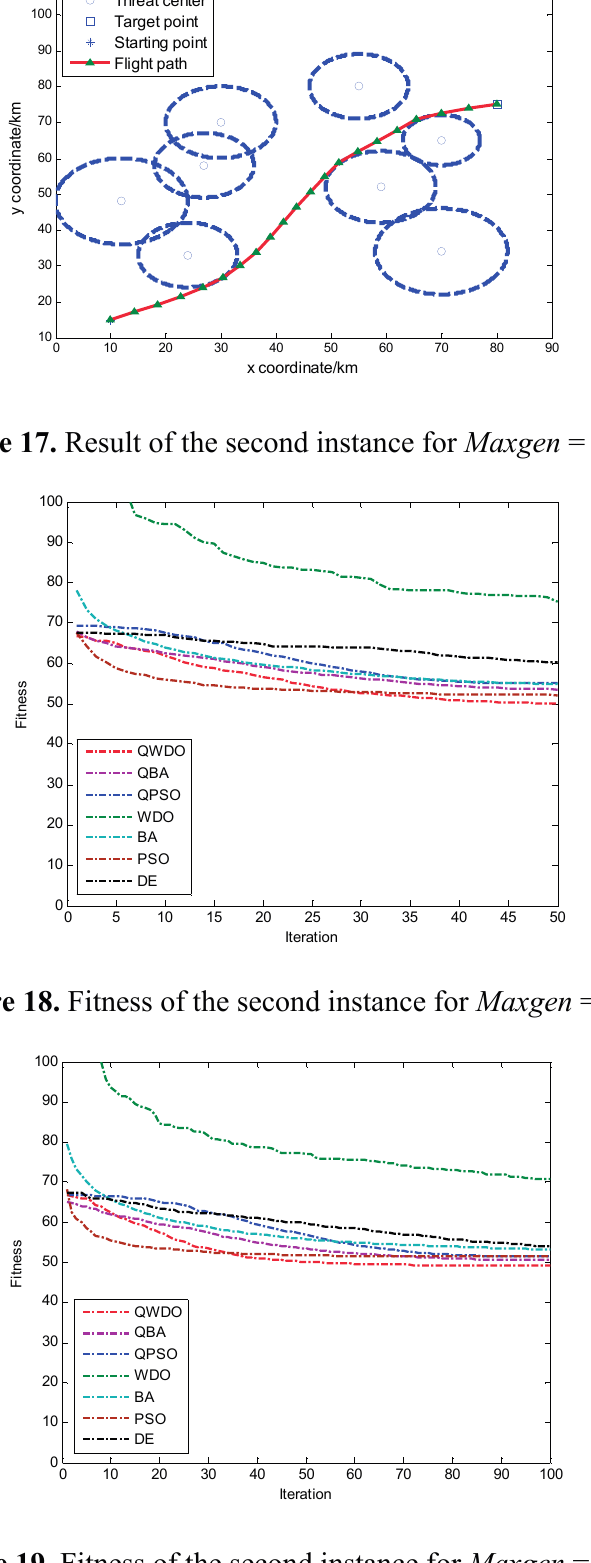
Figure 19. Fitness of the second instance for Maxgen =